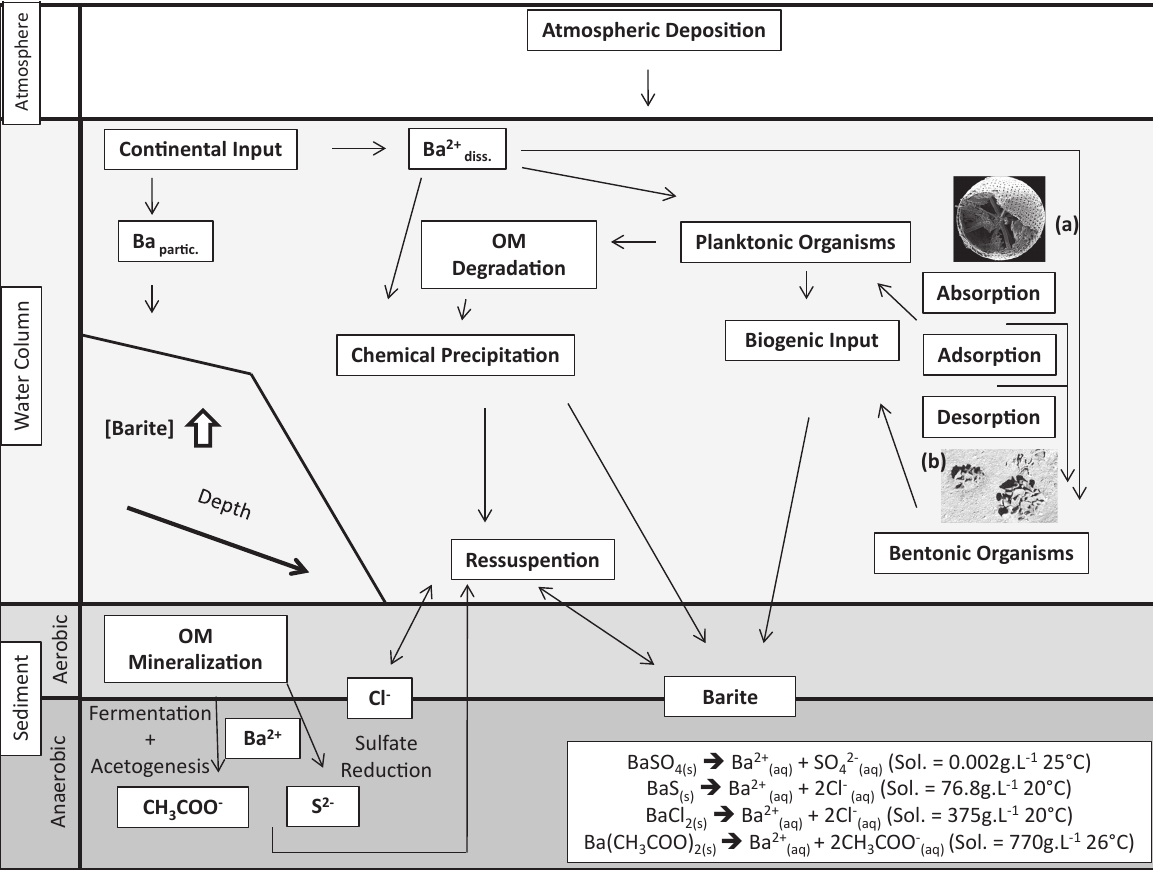
Figure 1 - Barite formation mechanisms along the water column {Adapted from Monnin et al. (1999)} . ( a - Acantharia illustrating planktonic organisms; b - Xenophyophore representing benthic organisms )